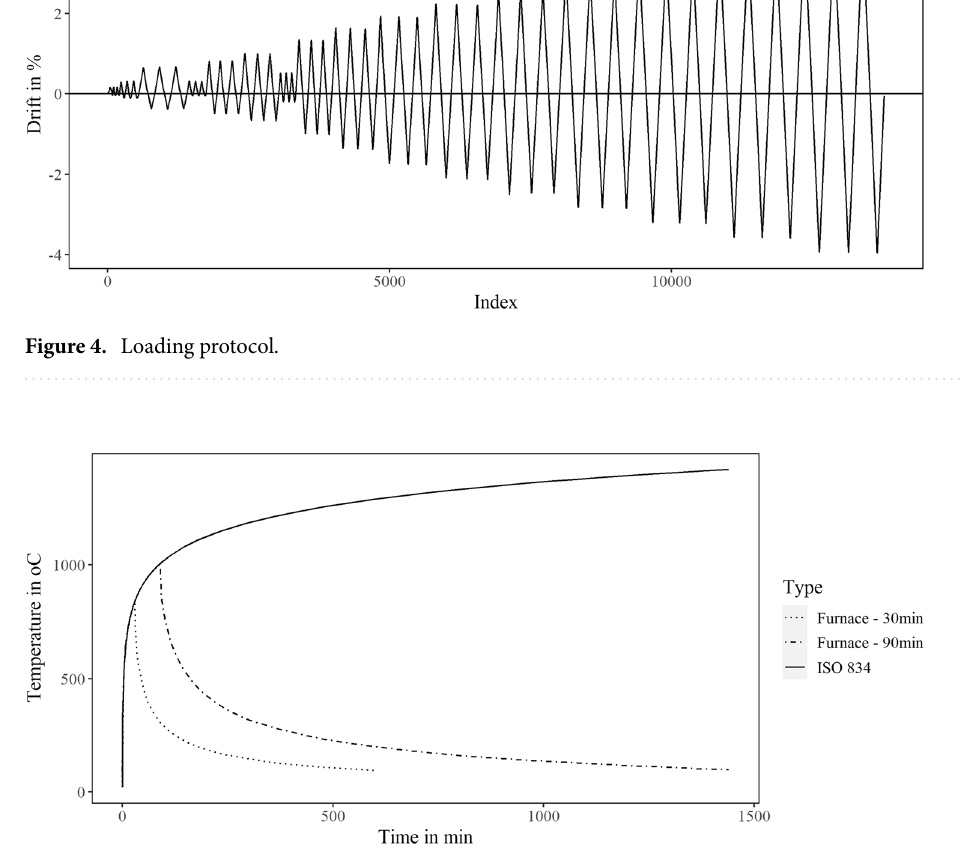
Figure 5. Experimental fire-temperature